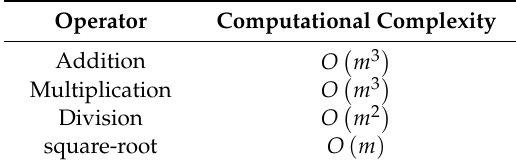
Table 1. Computational complexity of the proposed mitigation